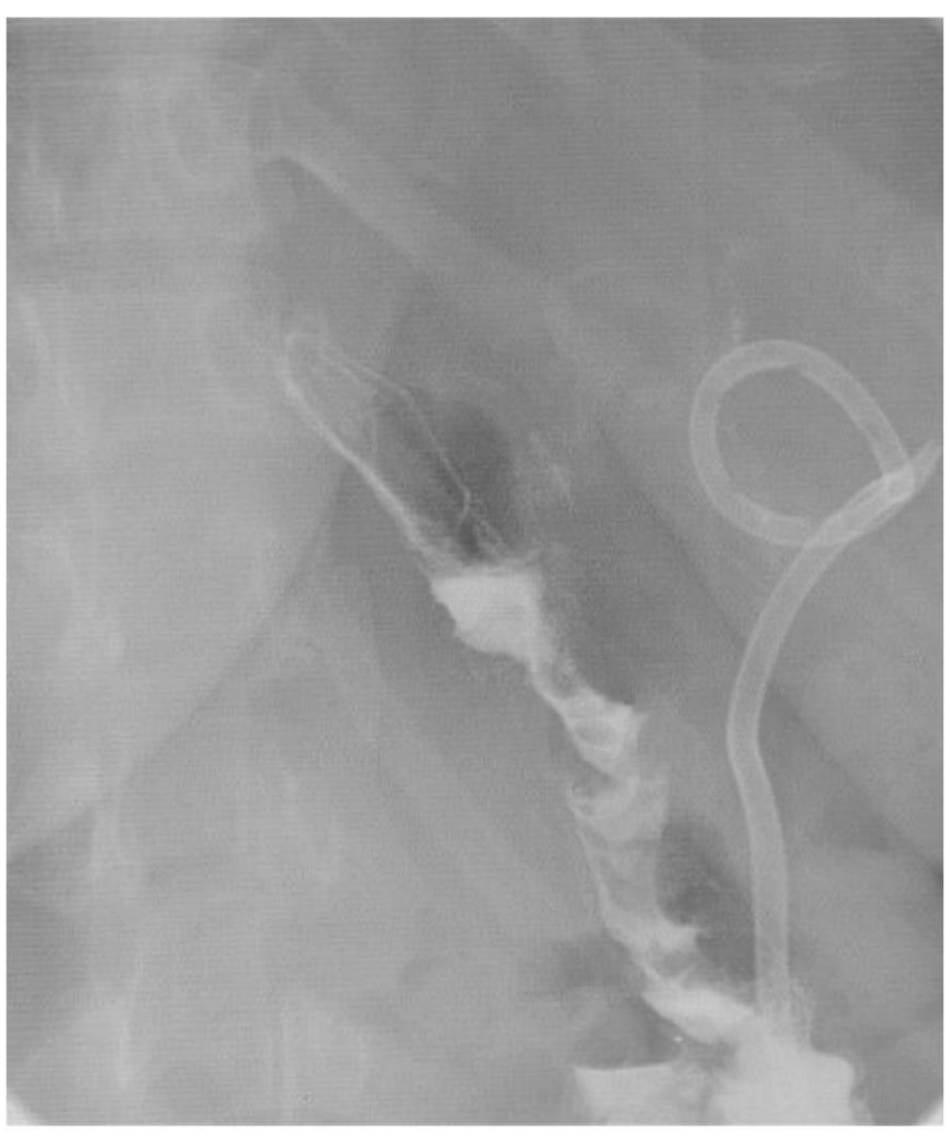
Figure 2. UGI series showing no leak from proximal stomach. After three weeks, a follow-up sinogram showed no residual cavity, and the drain was removed. However, the patient was admitted shortly thereafter due to severe pain. A repeat CT scan (Figure 3) showed a multiloculated fluid collection above the remnant stomach that had been separated from the previous